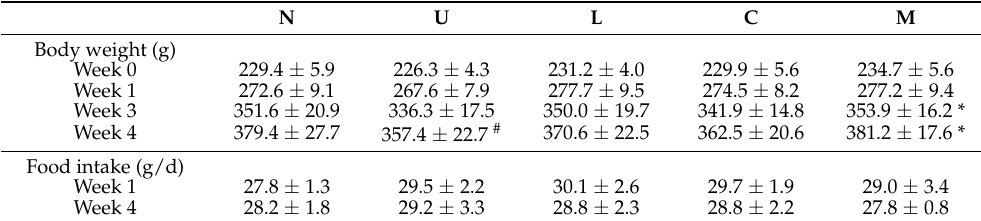
Table 1. Body weight and food intake in rats with or without dextran sulfate sodium-induced colitis 1 . N U L